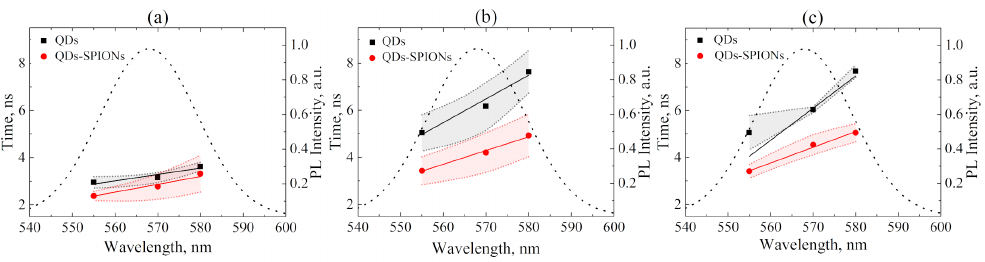
Figure 9. Dependence of the average PL decay time of QDs and QD-SPION nanocomposites on the acquisition wavelength for 4 ( a ), 24 ( b ), and 48 ( c ) hours of incubation in HeLa cells; the dotted curve shows the PL spectrum of QD solution in